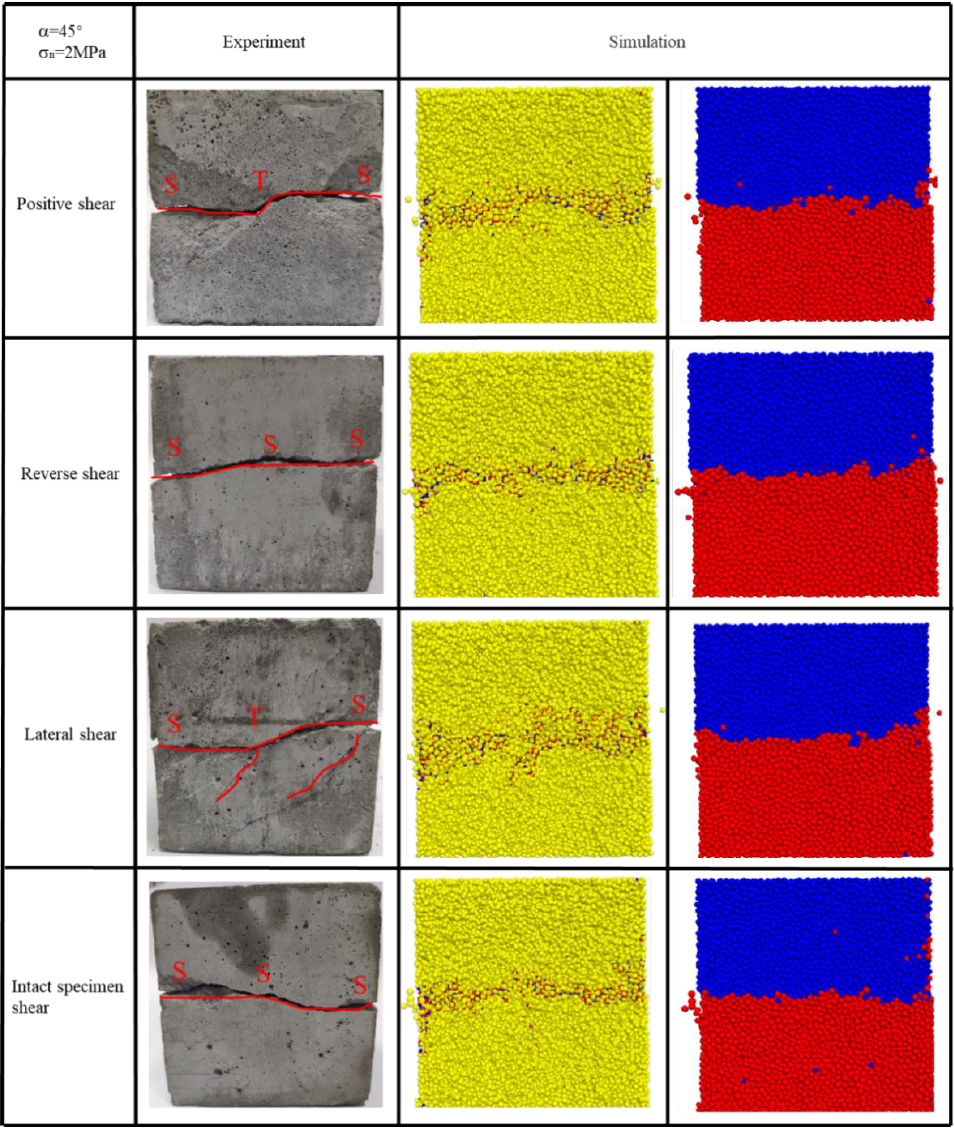
Figure 19. Comparison of failure modes between four groups of model samples and physical tests.